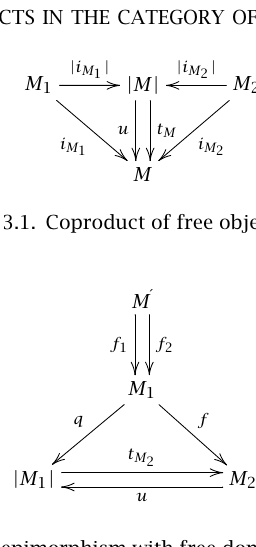
Figure 3.2 . A regular epimorphism with free domain has a free